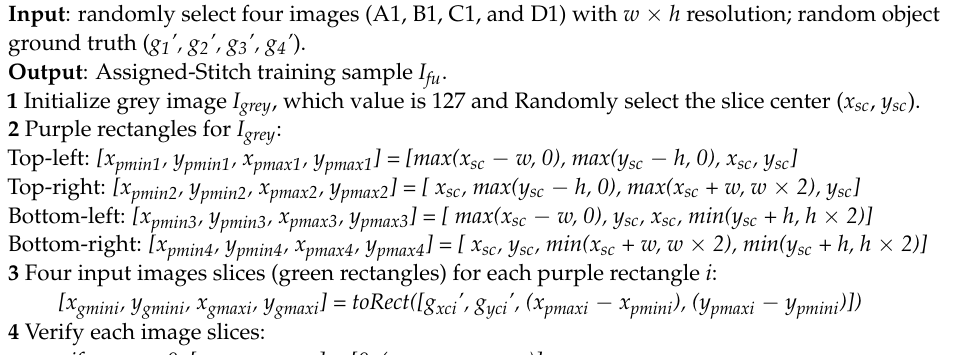
Algorithm 1 details the Assigned-Stitch procedure. Algorithm 1.